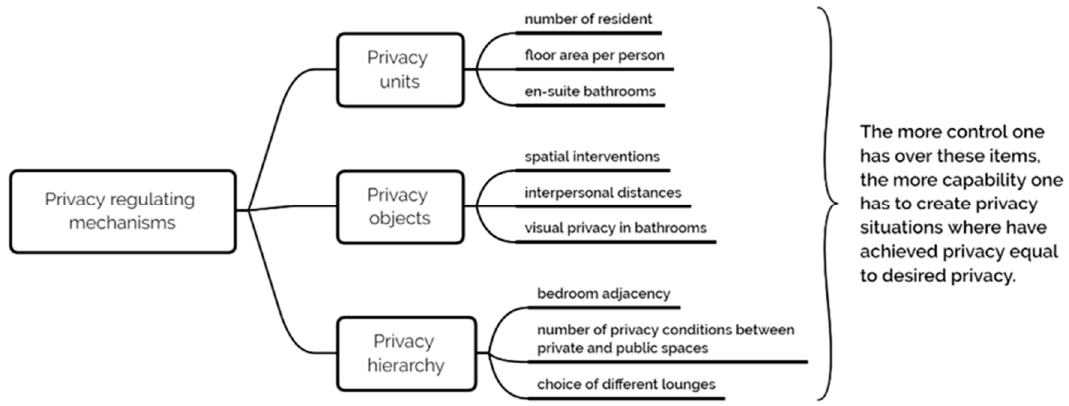
Figure 1. Framework for privacy design in nursing homes.